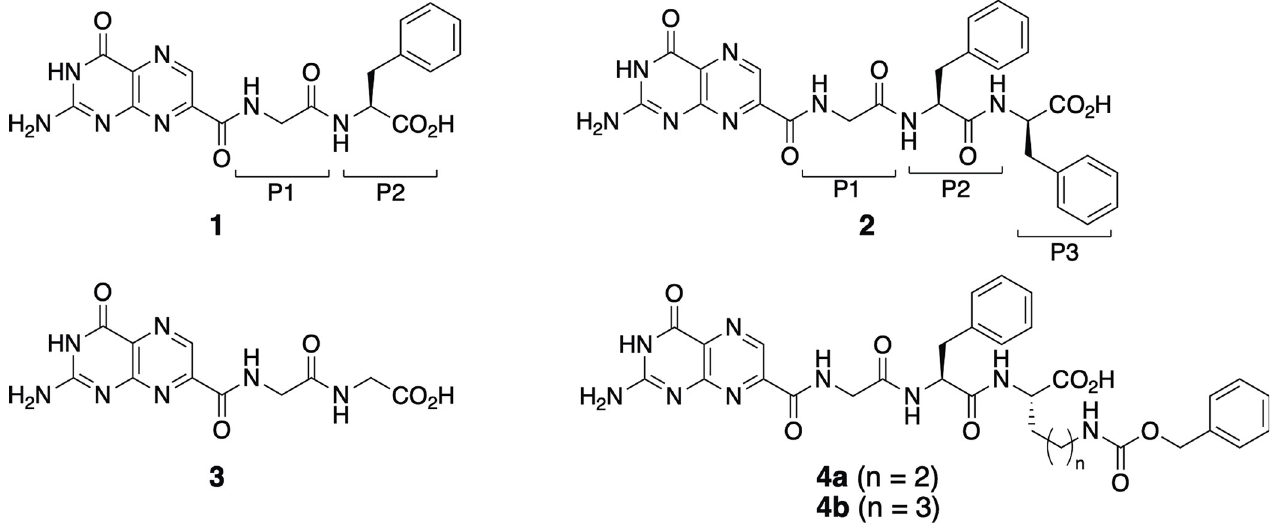
Fig 1. Structures of pterin-7-carboxamides